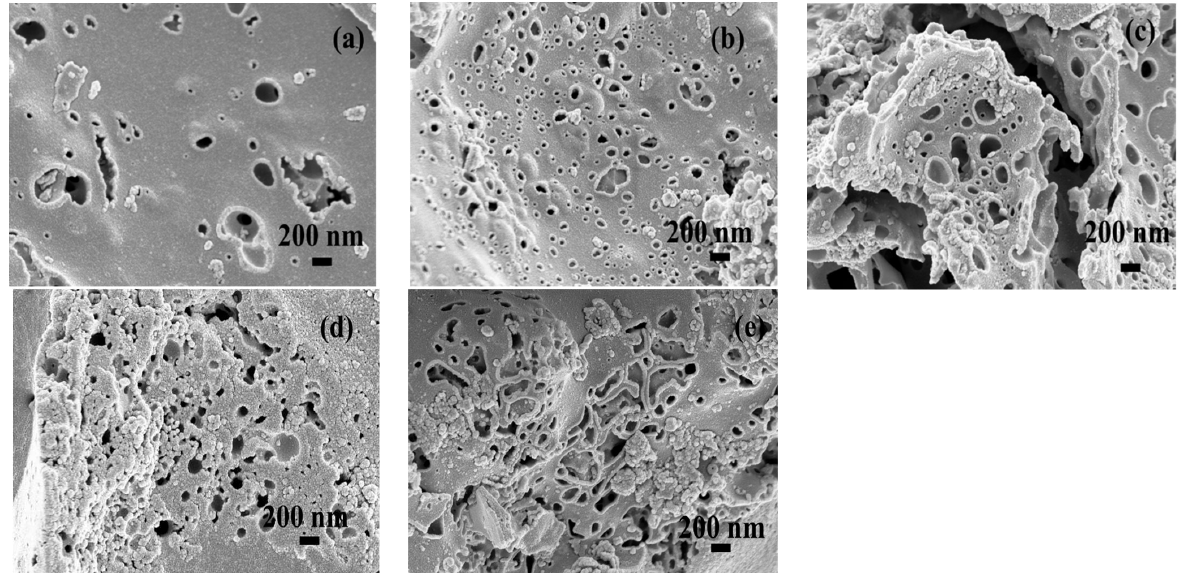
Figure 5. The surface morphology of activated carbon samples examined by SEM: ( a ) run 15; ( b ) run 20; ( c ) run 21; ( d ) run 2; ( e ) optimal.